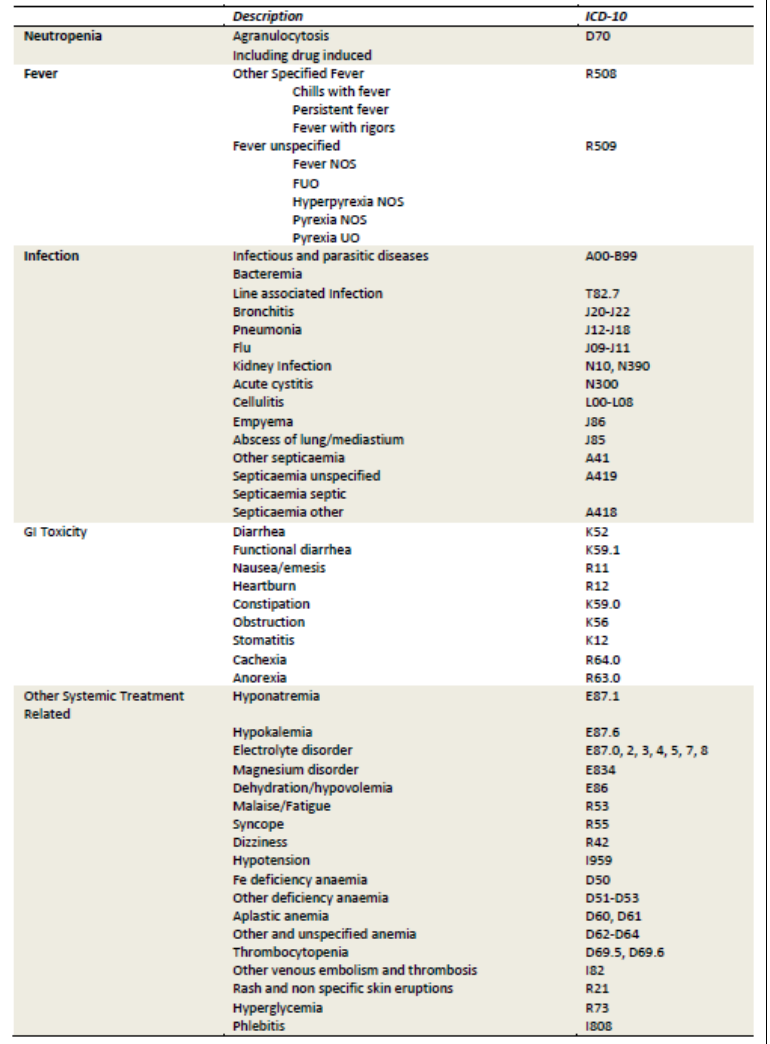
Figure A7. List of ICD-10 codes reflecting chemotherapy related toxicities. Adapted from Enright et al., J. Oncol. Pract . 2015 , 11 , 126–132 [19] (permission obtained from corresponding author).